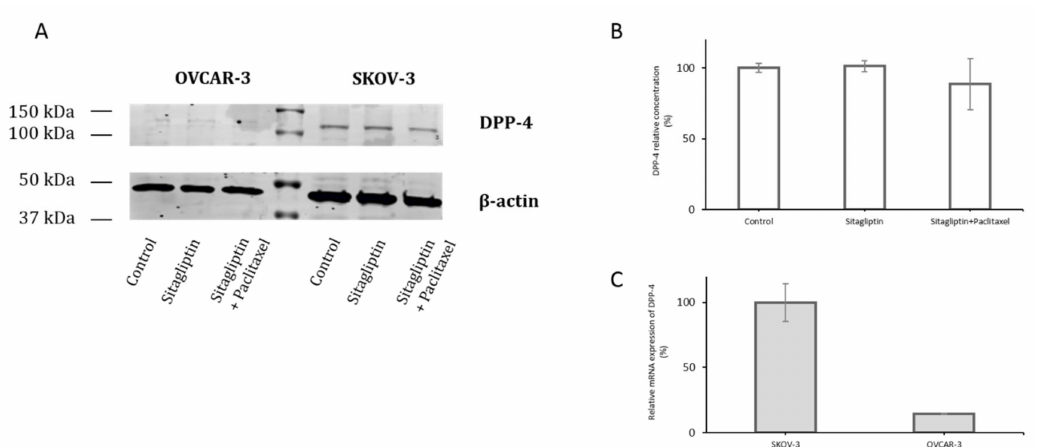
Figure 2. Dipeptidyl-peptidase 4 (DDP-4) (CD26) western blot and mRNA expression in ovarian cancer cells. Representative western blot image of protein extracts from OVCAR-3 and SKOV-3 ( A ). SKOV-3 cell line—control, cells stimulated for 24 h with sitagliptin (50 µ M), sitagliptin (50 µ M), and paclitaxel (10 nM). DPP-4 densitometry normalized protein concentration ( B ). Relative mRNA expression of DPP-4 assessed by qPCR ( C ).